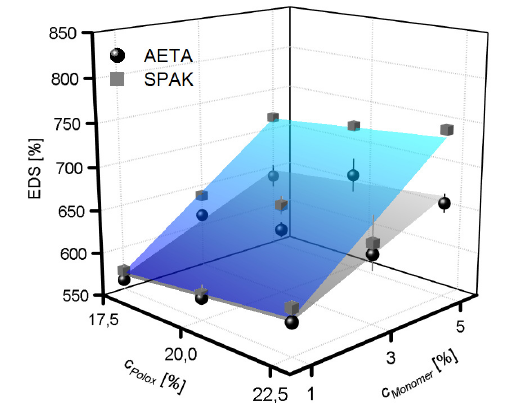
Figure 2. Equilibrium degree of swelling (EDS) of cross-linked hydrogels with varying concentrations ( c Monomer ) of positively and negatively charged monomers. The surface fits to the data points are to guide the eye only.